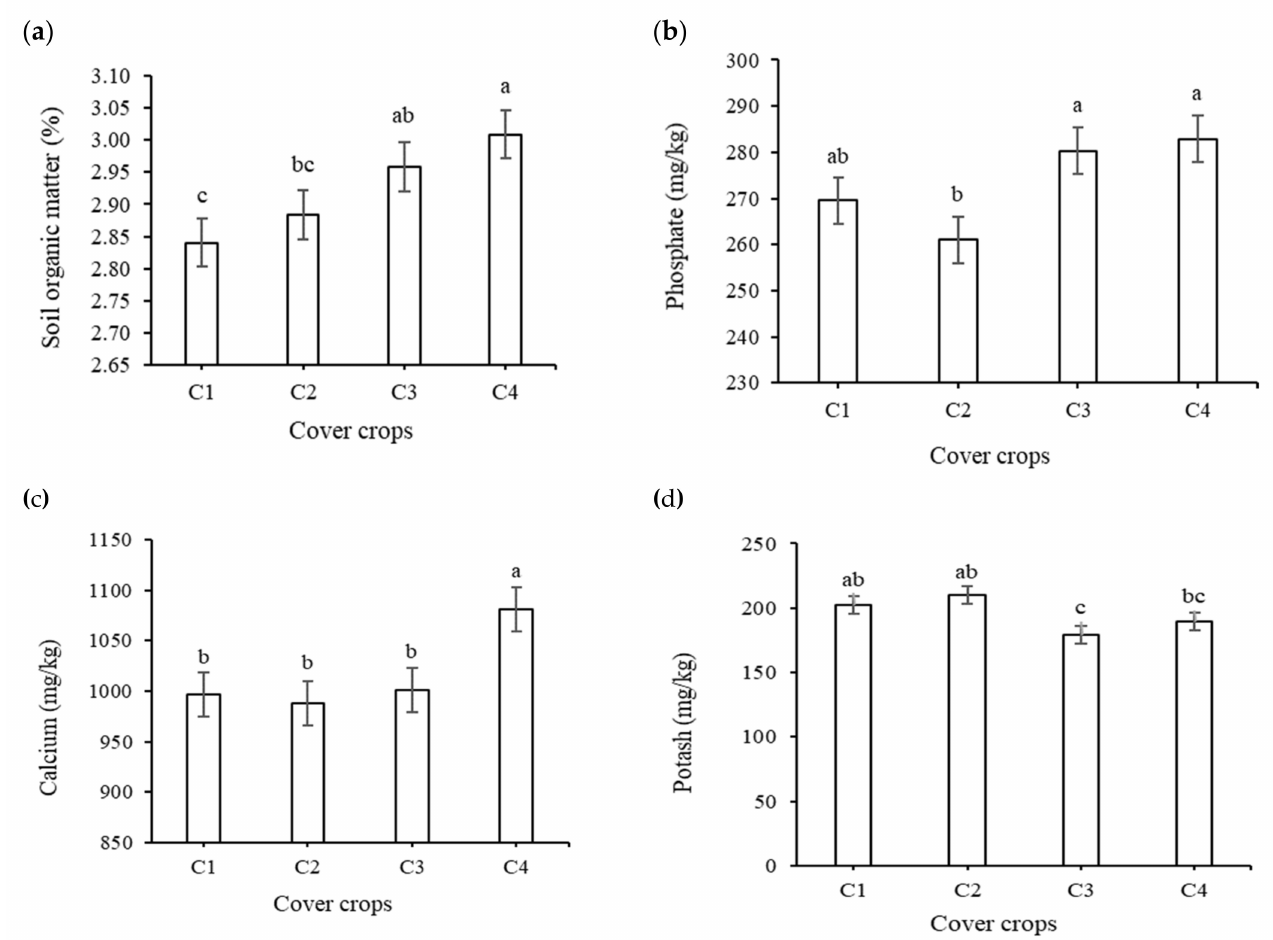
Figure 2. Multiple mean comparisons and standard error bars of ( a ) soil organic matter, ( b ) phosphate, ( c ) potash, and ( d ) calcium concentration in soils of treatments C1 (timothy), C2 (buckwheat), C3 (brown mustard), and C4 (mix (hairy vetch, annual rye, and crimson clover) using Fisher’s least significance difference (LSD) method. Treatments labeled with the same or combination of LSD letters (a, b, c) are not significantly different from one another. Treatment means sharing labels with different LSD letters that are significantly different from one